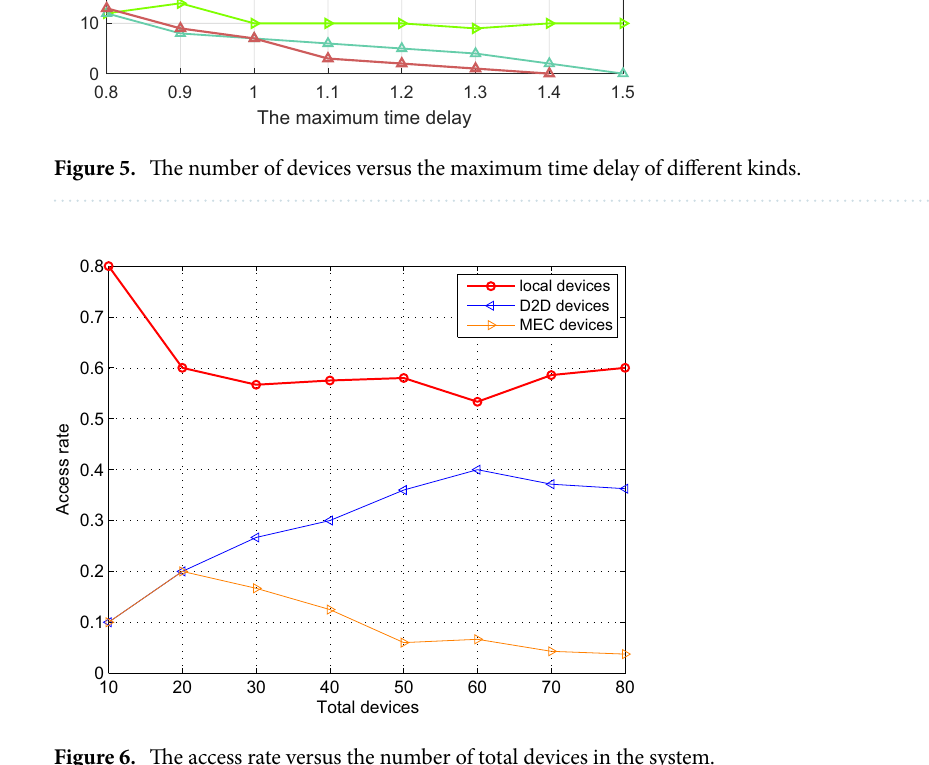
Figure 6. The access rate versus the number of total devices in the